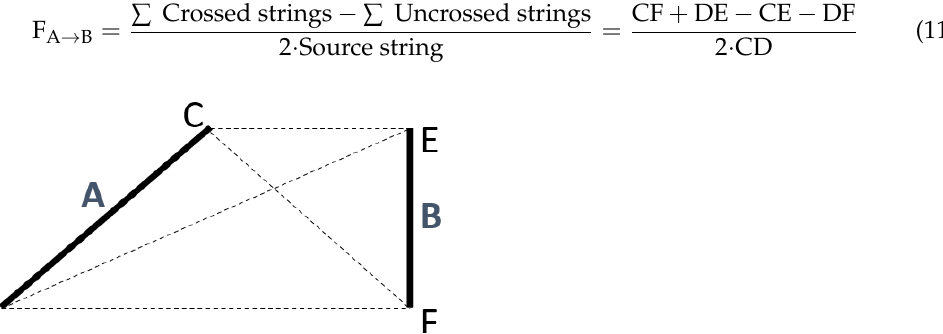
Figure 6. Calculation of view factor: two surfaces of infinite length applying Hottel’s crossed-string rule.